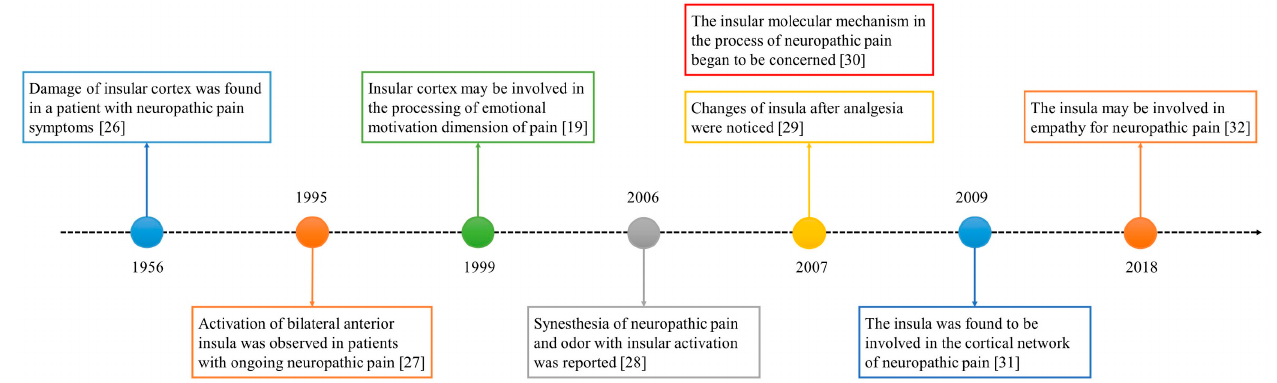
Figure 1. The development timeline of the insular lobe and neuropathic pain.